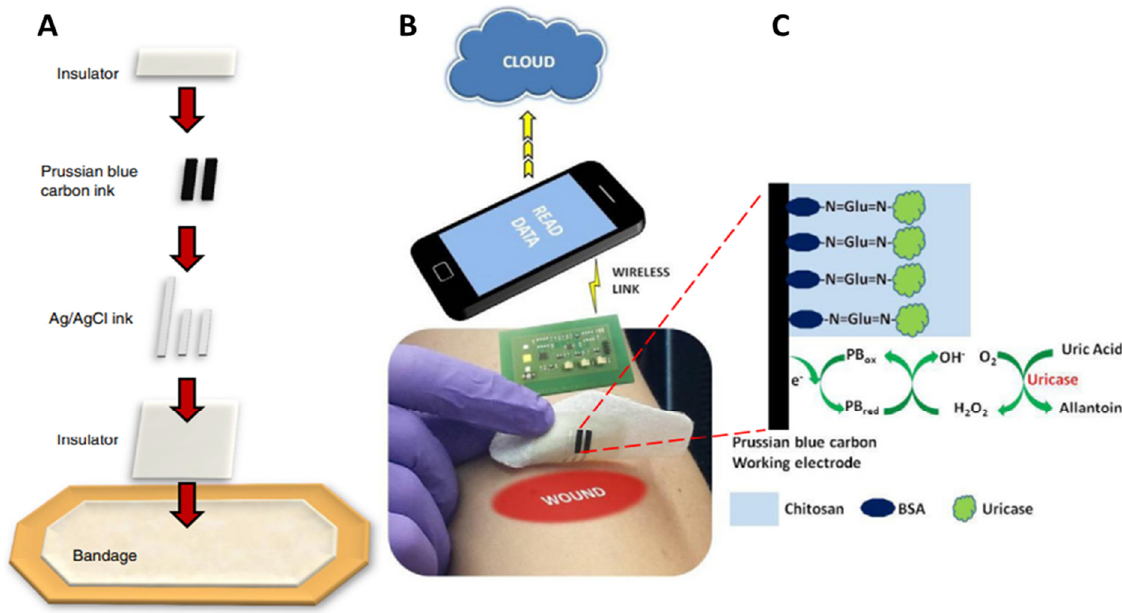
Figure 9. Biochemical sensors: ( A ). Screen printing the smart bandage. ( B ) . Wearable potentiostat determining uric acid concentration and wirelessly communicating with a computer or smartphone. ( C ). Schematics showing amperometric detection of uric acid with uricase immobilized on a PB working electrode. Reprinted with permission from Electrochemistry Communications, Copyright 2015, [119].